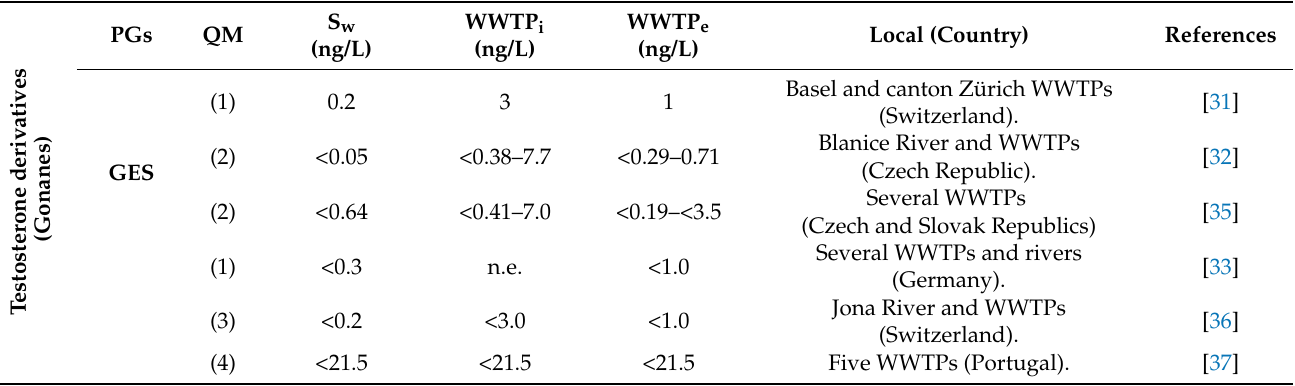
Table 2. Concentrations of synthetic progestins in waste and surface waters. Average (Av);